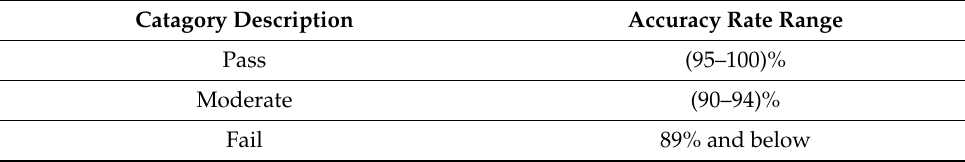
Table 3. Accuracy rating